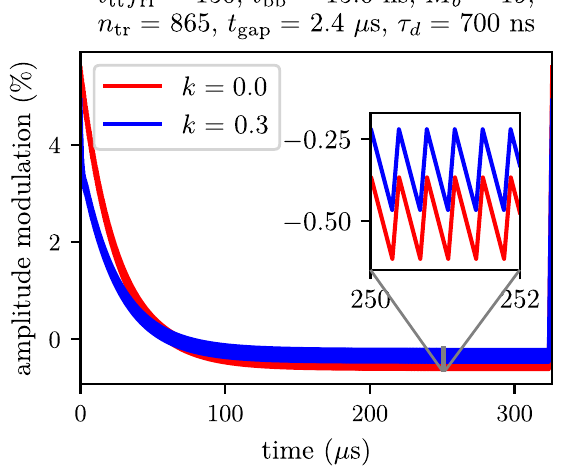
FIG. 8. Comparison of amplitude modulation of the cavity voltage with the direct rf feedback for different compensation factor k